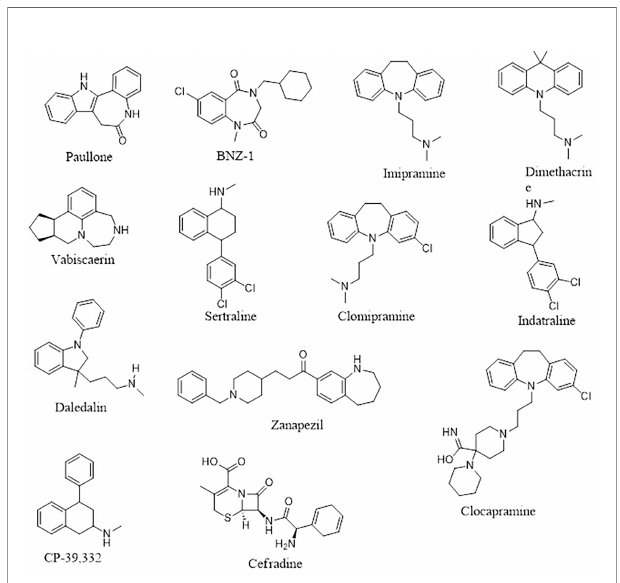
FIGURE 8 | The 2D representations of the compounds cited from